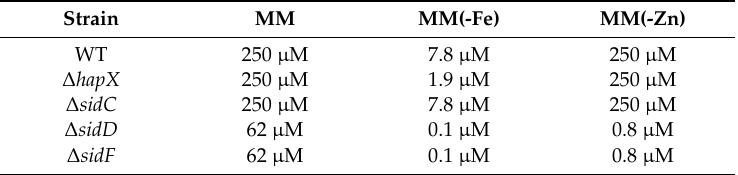
Table 1. Pyochelin minimal inhibitory concentration (MIC) on WT and mutants deleted in iron-stress responses ( ∆ hapX ) or siderophore ( ∆ sidC, ∆ sidD, ∆ sidF ) in MM medium or MM depleted in iron